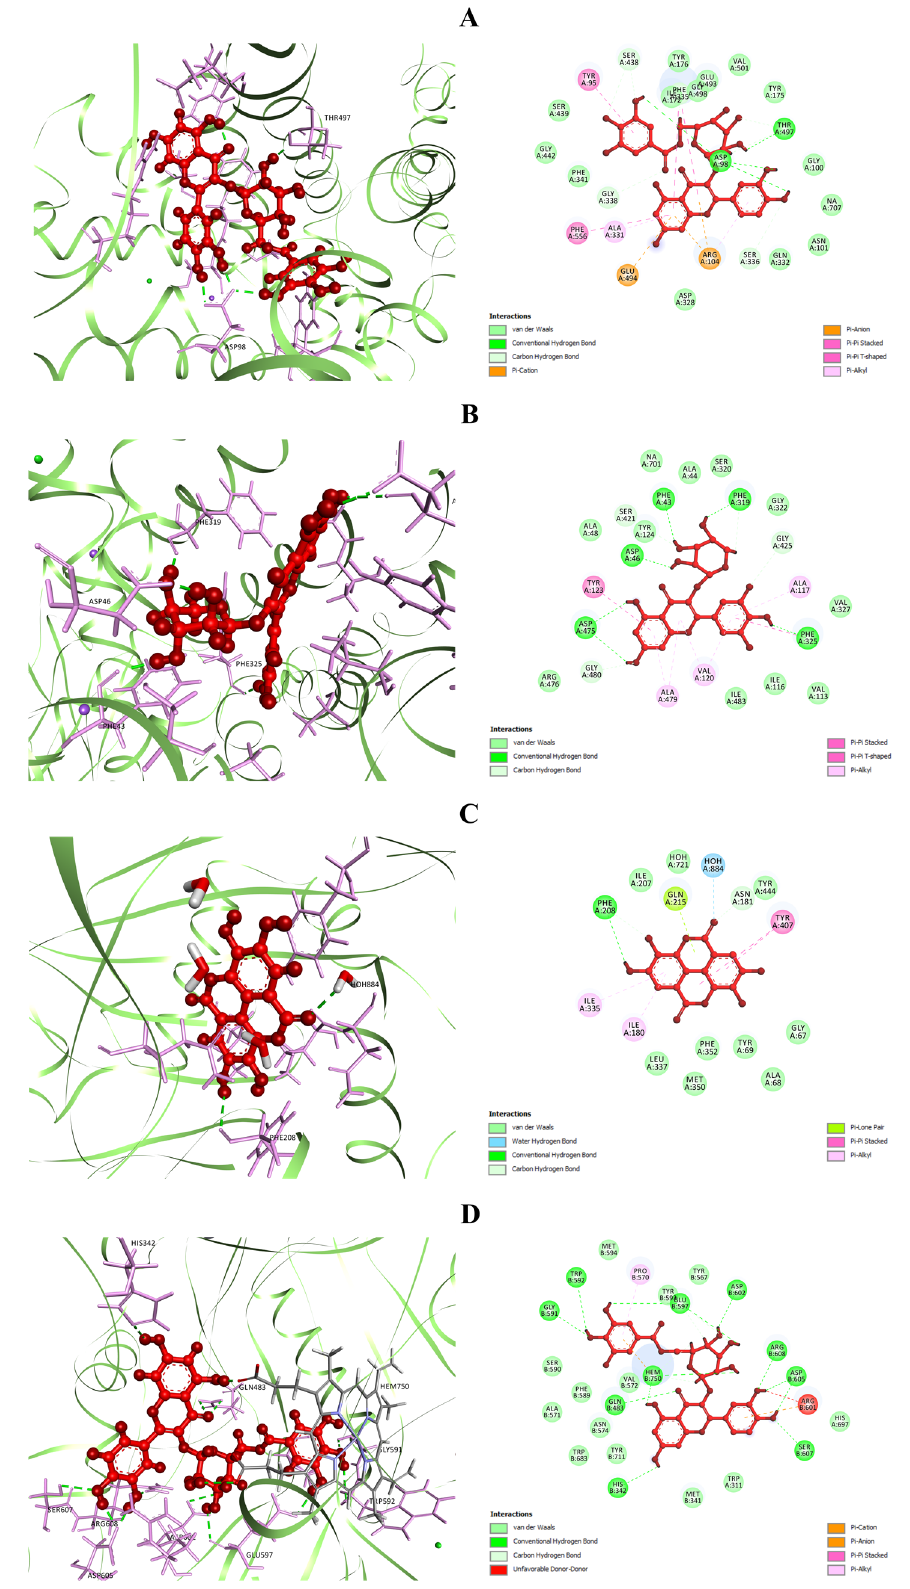
Figure 6. Best ranked docking pose (left), and 2D visualization of the interactions (right) of ( A ) Q3DG, ( B ) M3LA, ( C ) EA, and ( D ) Q3DG with active site residues of SERT3 (PDB ID: 5I6X), DAT (PDB ID: 4M48), MAO-A (PDB ID: 2Z5Y), and nNOS (PDB ID: 4UH5), respectively.